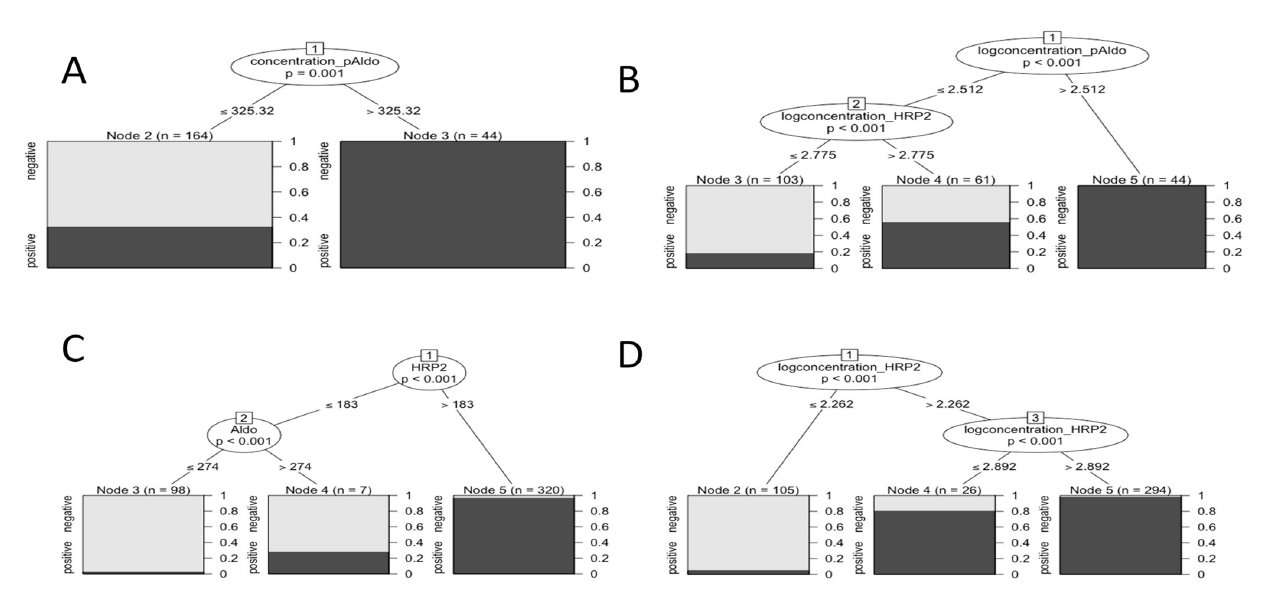
Fig 2. Conditional inference trees using HRP2, pLDH, and pAldolase antigen concentration for classification of Plasmodium falciparum presence or absence as determined by PCR assay. A) Angola (sen-qPCR). B) Angola (sen-qPCR), log scale. C) Haiti (PET-PCR). D) Haiti (PET), log scale. Y-axes at base of trees indicate probability of correct classification on a scale of 0.0 to